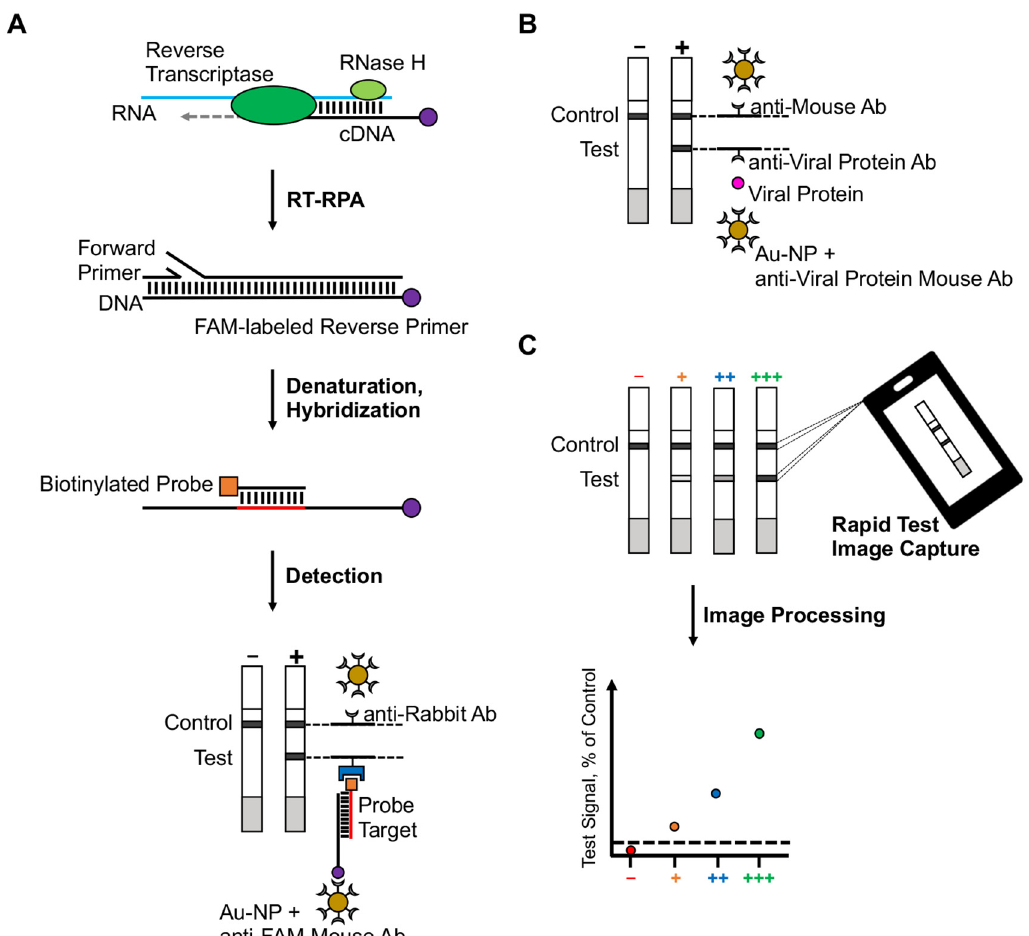
Figure 1. Schematic of RT-RPA assay versus antigen-based test. ( A ) In RT-RTPA, viral RNA is coped to cDNA by reverse transcriptase, then degraded by RNase H. Using a forward and a FAM-labeled reverse pair of primers specific to a target sequence, the cDNA product is amplified by RPA, then denatured and hybridized to a biotinylated probe. FAM-labeled and biotin-labeled products are detected on a lateral flow strip using molecules specific for FAM and biotin and nanoparticles. ( B ) In an antigen test, protein targets are detected by a lateral flow strip using protein-specific antibodies and nanoparticles. ( C ) A mobile phone application was used to image capture, machine-read, and quantify test results. The average pixel intensity is quantified at the test line, control line, and background areas. The background-subtracted test line signal is then normalized to the background-subtracted control line and expressed at % of control. – (red), test signal below the limit of detection; + (orange), low test signal; ++ (blue), medium test signal; +++ (green), high test signal.